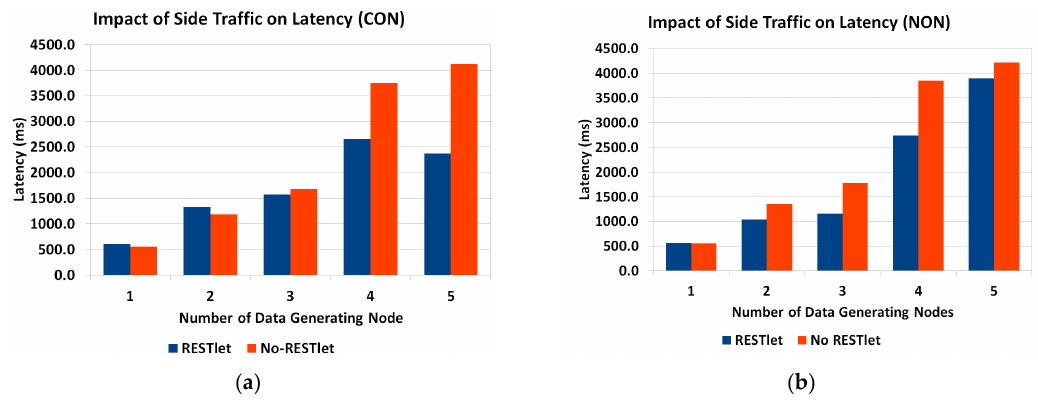
Figure 22. Impact of Side Traffic on Latency. ( a ) CONfirmable; ( b ) NON-Confirmable transaction.